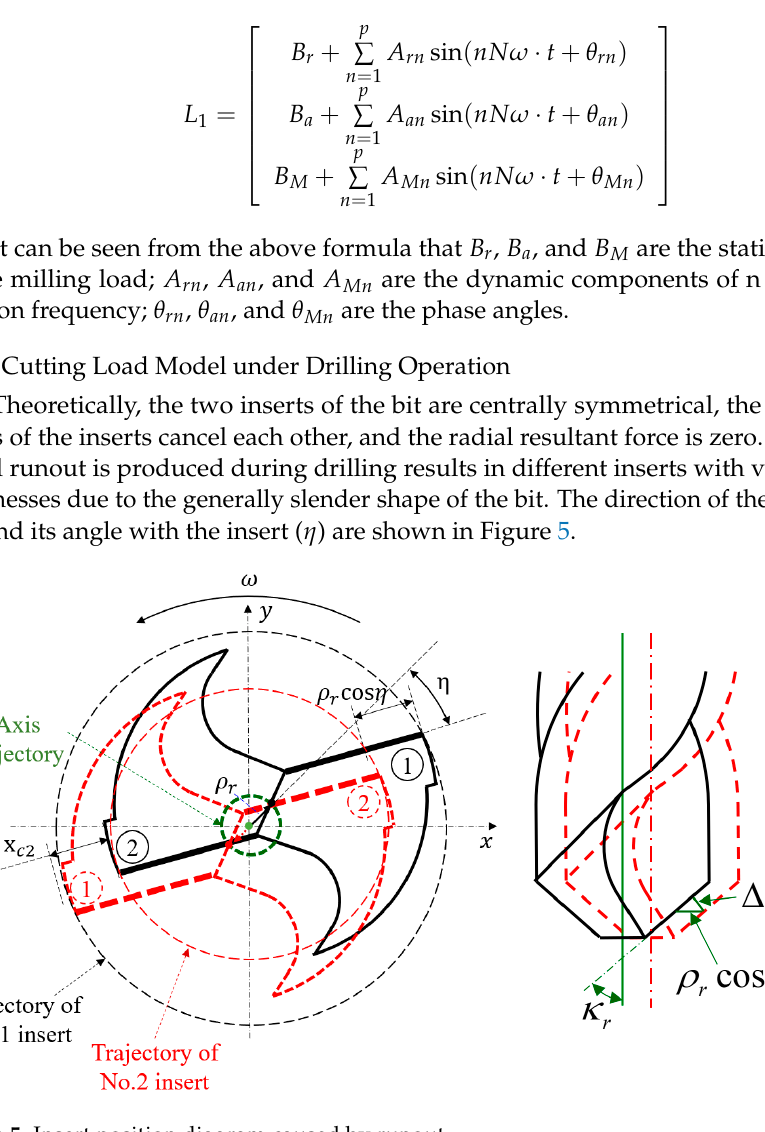
tion and the insert, and ∆ h r is the change in uncut chip thickness caused by radial runout. radial direction (cutting thickness direction) is ρ r cos η , and the runout component along